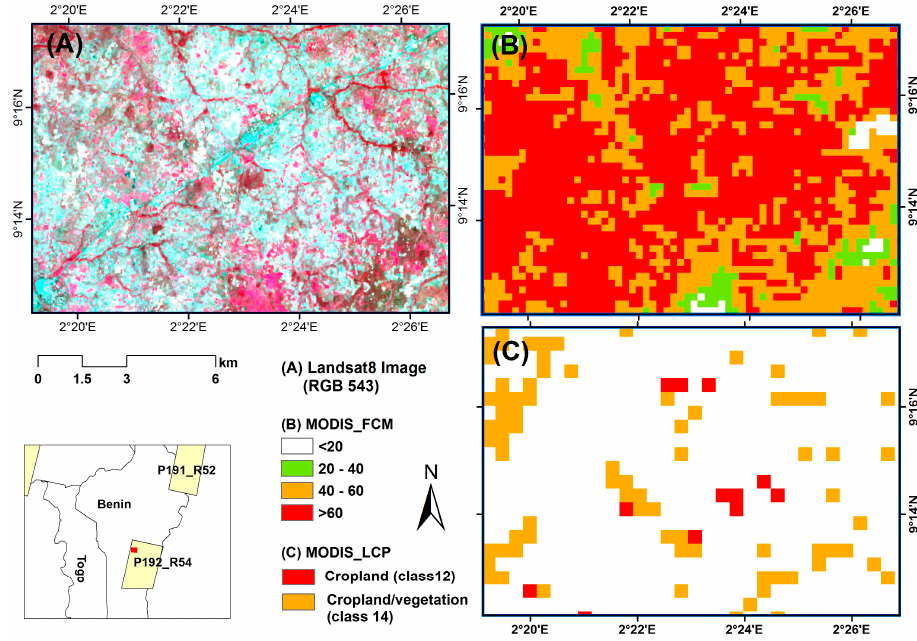
Figure 11. Comparison of a Landsat (P192_R54) false color composite ( A ) with subsets of the two MODIS scale products: MODIS_FCM ( B ) and MODIS_LCP ( C ).